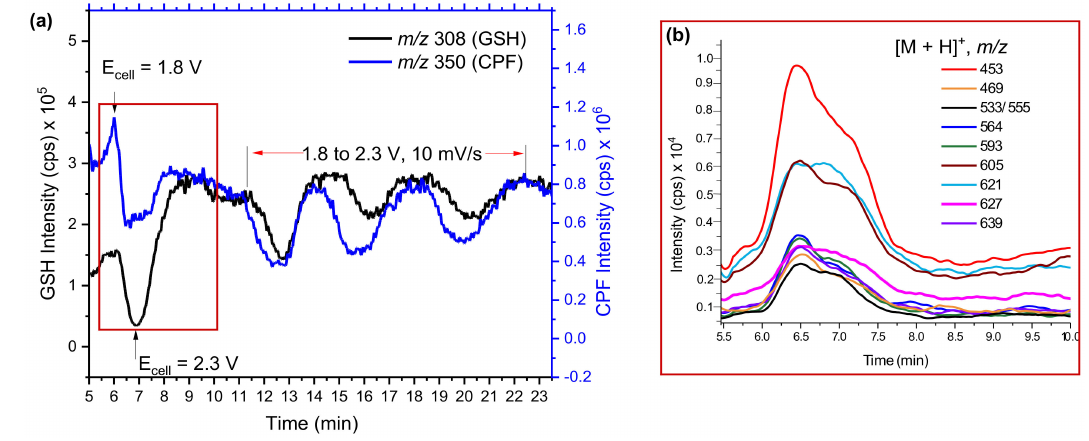
Figure 1. Mass voltammograms of CPF (1800 → 2300 mV, 10 mV/s) and GSH (0 mV) ( a ) and intensity of possible conjugates ( b ) measured by EC/MS using BDD in µ PrepCell TM